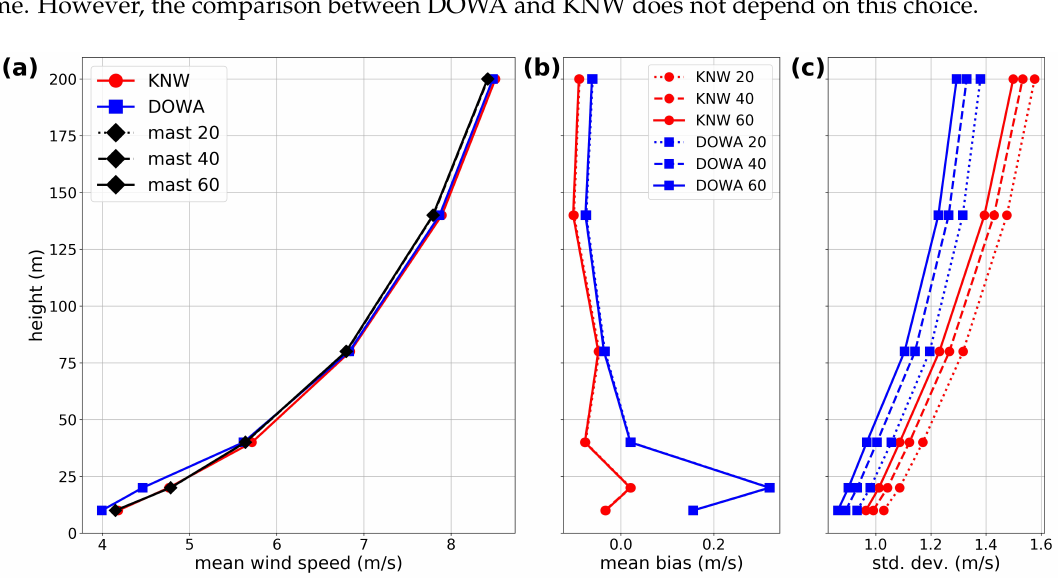
Figure A1. Height profile of ( a ) the mean wind speed, ( b ), mean bias and ( c ) the standard deviation of the bias, showing mast measurements (black), DOWA (blue), and KNW atlas (red), for different averaging times (20, 40, and 60 min) of the mast measurements.